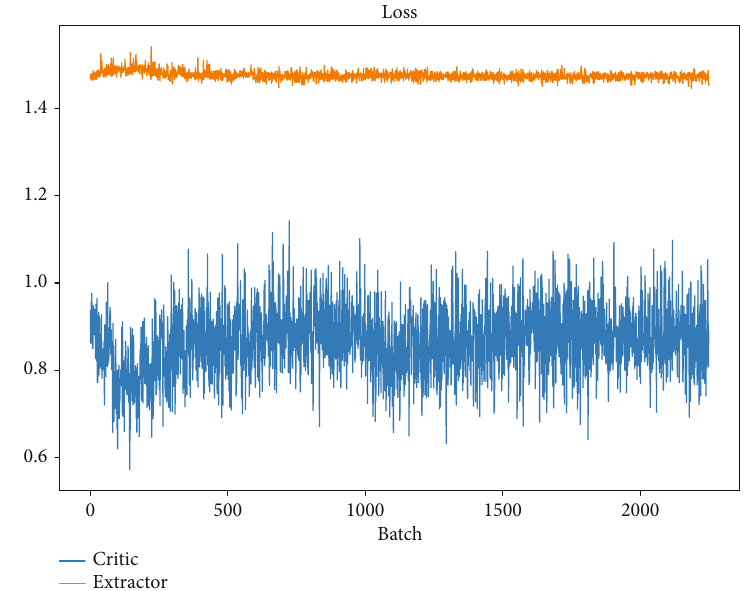
Figure 8: Training process of task 3 ⟶ 0 using